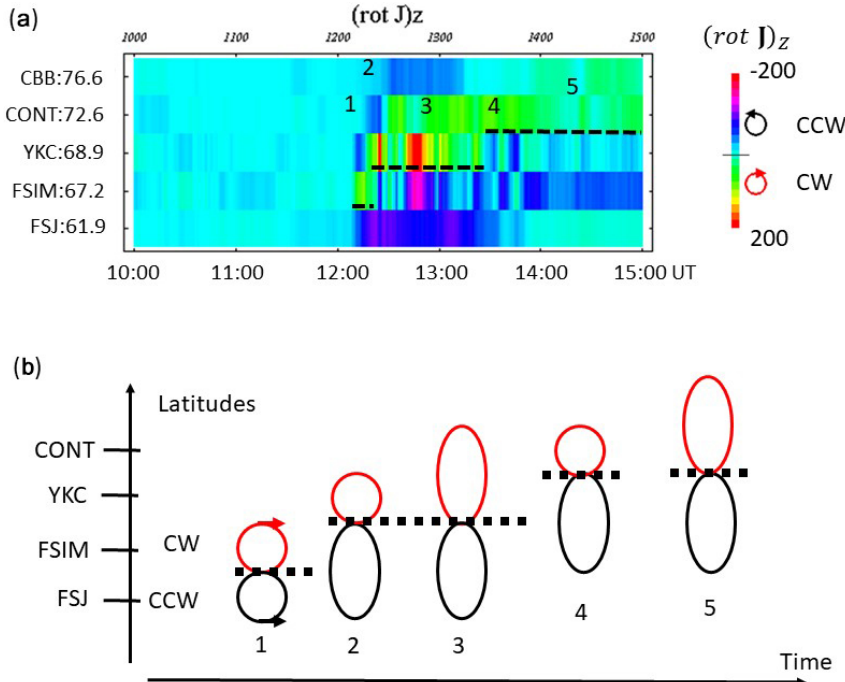
Figure 7. (a) Vertical component of ( rot J ) Z in the meridian chain along 300 ◦ E for the interval from 10:00 to 15:00UT, reproduced from Saka and Hayashi (2017). Dipolarization onset was at 12:13UT at this meridian. For the calculation of ( rot J ) Z , vertical component data from RES (83.0 ◦ N, 299.7 ◦ E), CBB (76.6 ◦ N, 301.2 ◦ E), CONT (72.6 ◦ N, 298.3 ◦ E), YKC (68.9 ◦ N, 298.0 ◦ E), FSIM (67.2 ◦ N, 290.8 ◦ E), FSJ (61.9 ◦ N, 295.5 ◦ E) and VIC (54.1 ◦ N, 296.7 ◦ E) along the magnetic meridian 300 ◦ E were used (see text): positive for the clockwise rotation (CW) of ionospheric currents and negative for the counterclockwise rotation (CCW) viewed from above the ionosphere. Amplitudes are color-coded. The scale is shown on the right. Demarcation lines separating CCW and CW in latitudes are marked by a dashed line. The demarcation line moved to poleward after the onset. Note that negative ( rot J ) Z in the poleward edge indicates a smooth decrease in the Z amplitudes. (b) Time progressions of the CW and CCW patterns are illustrated separately in five segments from 1 to 5, marked in Fig. 7a. The figure demonstrates a progression of the CW–CCW pair in time, CW in the poleward and CCW in the equatorward. This pair developed its size after onset, showing poleward expansion. The meridional current associated with this pair of loop currents, if closed in the equatorial plane via the field-aligned currents, comprised the Bostrom-type current